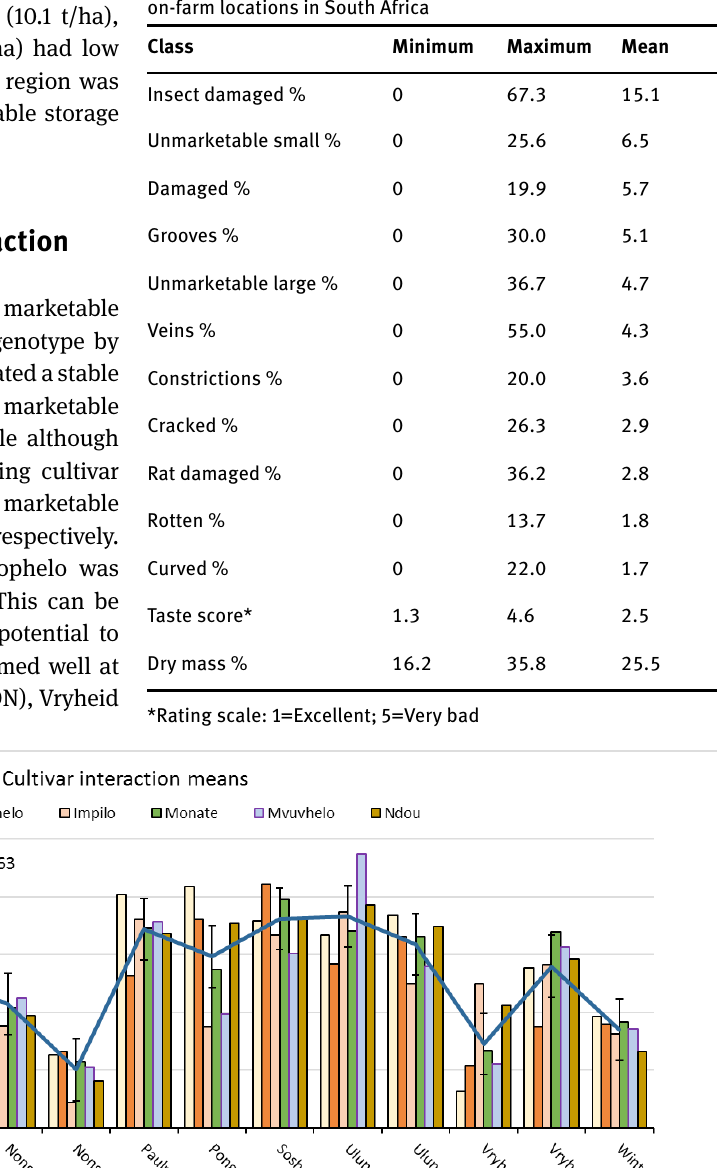
Table 5 : Mean values and range for unmarketable storage root classes, taste acceptability score and dry mass content over 15